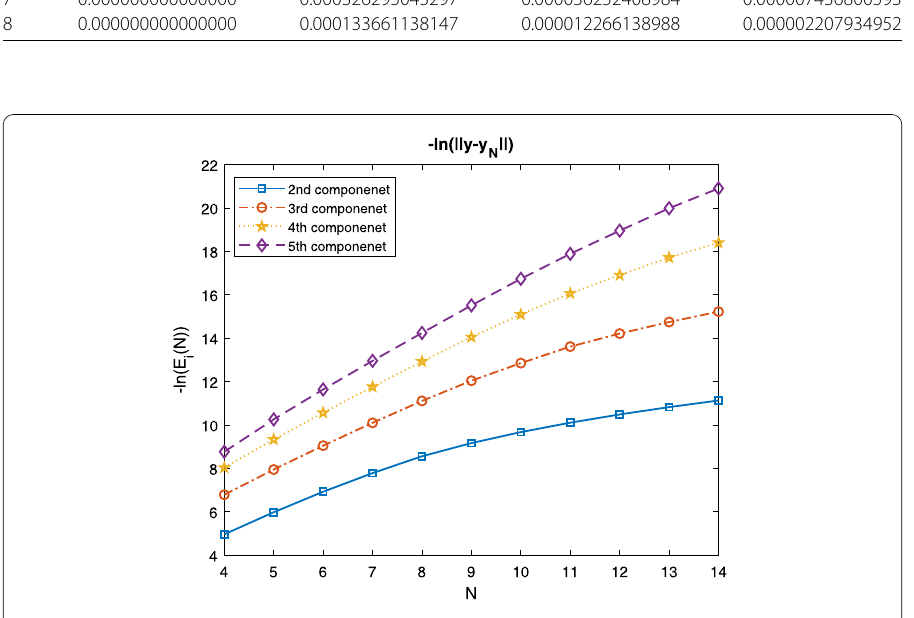
Figure 1 The natural logarithm of the (cid:12) y – y N (cid:12) ∞ versus N , in Example 8.2